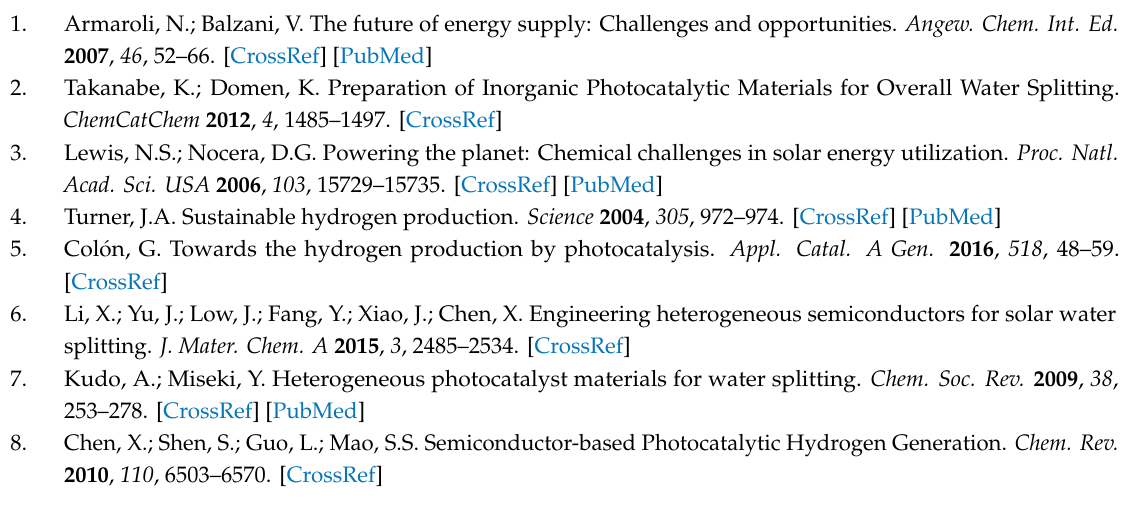
Table S1: Synthesis method, reaction conditions and H 2 production rates of selected MoS 2 / C 3 N 4 based photocatalysts, Table S2: Elemental composition of as-synthesized and used catalysts derived from CHNS and ICP-OES, Table S3: Surface elemental composition of as-synthesized and used catalysts derived from XPS, Table S4: Structural properties of as-prepared catalysts. Figure S1: XRD powder patterns of Pt / CN and Pt / MoS 2 -C 3 N 4 composite catalysts removed from the reactor after 6 h irradiation under UV-vis light in the presence of lactic acid, Figure S2: DRS UV-vis spectra of 2H MoS 2 (HT), 1T MoS 2 (ST) and 2H MoS 2 (TD), Figure S3: STEM high angle annular dark field (HAADF) micrographs of CN phase decorated with Pt (column l), high resolution HAADF (column m) and bright field (BF) micrographs (column r) of MoS 2 phase (when present) in catalysts exposed to UV-vis irradiation for 6 h in the presence of lactic acid; Figure S4: High resolution STEM-HAADF image with corresponding FFT of Pt / 2H MS-CN (SC), Figure S5: STEM-HAADF micrographs with corresponding EDX spectra of Pt / CN, Figure S6: STEM-HAADF micrographs with corresponding EDX spectra of Pt / 2H MS-CN (PD), Figure S7: STEM-HAADF micrographs with corresponding EDX spectra of Pt / 2H MS-CN (SC), Figure S8: STEM-HAADF micrographs with corresponding EDX spectra of Pt / 1T MS-CN (SC), Figure S9: STEM-HAADF micrographs with corresponding EDX spectra of Pt / 2H MS-CN (TD), Figure S10: XP spectra of C 1s: (a) Fresh catalysts; (b) Recovered catalysts after 6 h reaction, Figure S11: XP spectra of N 1s: (a) Fresh catalysts; (b) Recovered catalysts after 6 h reaction, Figure S12: XP spectra of O 1s: (a) Fresh catalysts; (b) Recovered catalysts after 6 h reaction, Figure S13: XP spectra of Pt 4f: Pt / CN, Pt / 2H MS-CN (PD) and Pt / 2H MS-CN (TD), Figure S14: (a) N 2 adsorption-desorption isotherms of CN and 2H MS-CN (PD); (b) Barrett-Joyner-Halenda pore size distribution plot, Figure S15: EPR signal of as synthesized catalysts at 300 K without light irradiation, Figure S16: Experimental setup for photocatalytic H 2